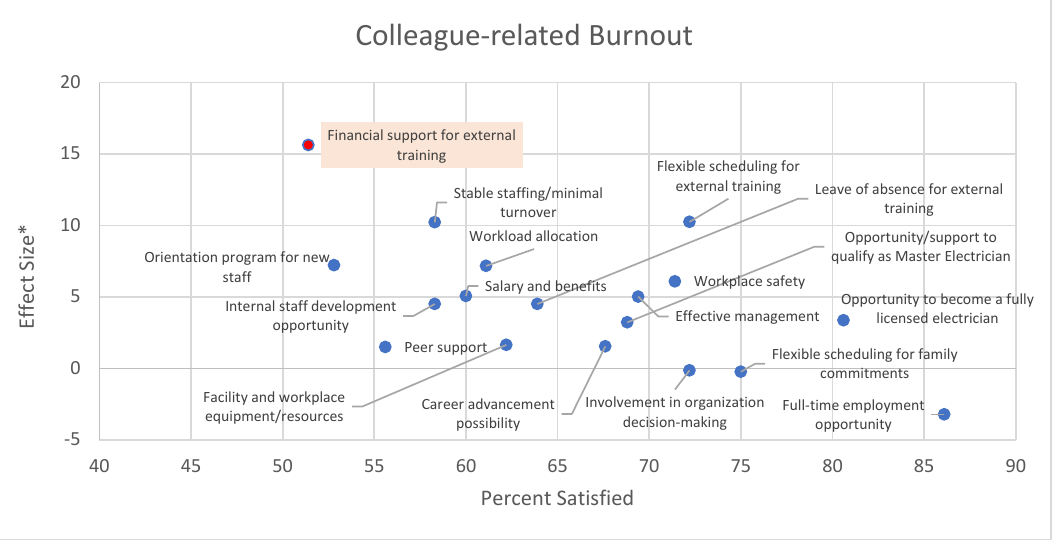
Figure 5. Impact of availability of work-related factors on colleague-related burnout. * Effect sizes is the difference in the average burnout score among those satisfied and those dissatisfied with the factor. Thus, positive effect sizes indicate higher burnout among those dissatisfied with the factor. The proportion satisfied is a measure of performance that indicates the proportion of the sample that stated to be satisfied or very satisfied with the availability of the factor. The red dot indicates statistical significance at an alpha level of 0.10 when comparing the average burnout score among respondents satisfied and dissatisfied with the factor.